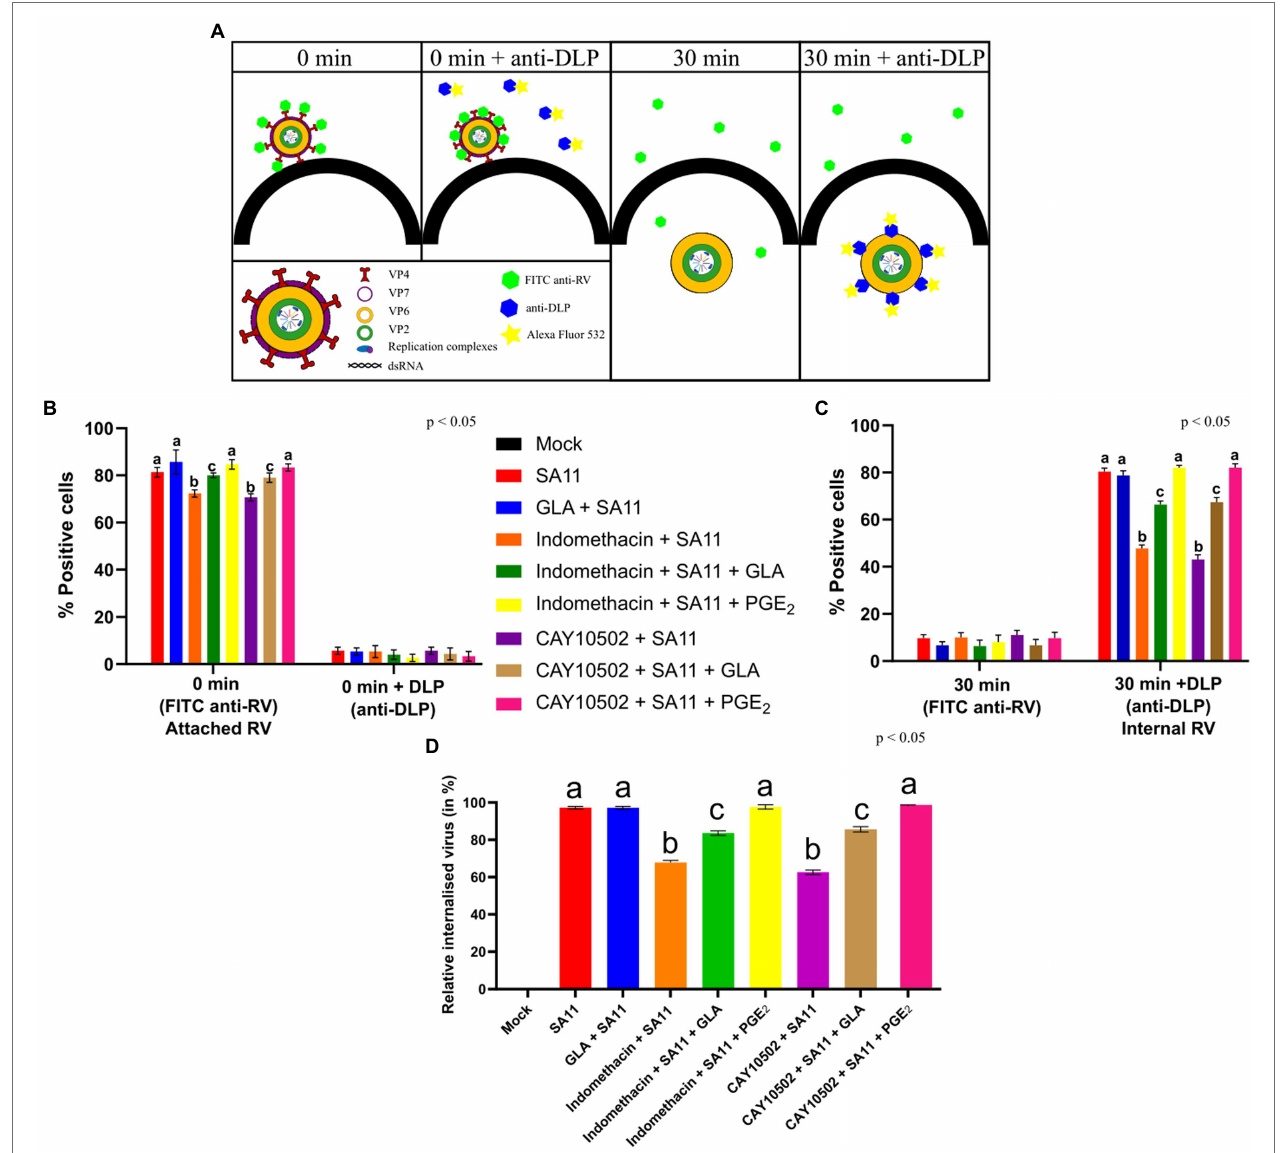
FIGURE 5 | Inhibition of PGE2 biosynthesis affects RV attachment and internalisation. (A) At time zero, RV at an MOI = 10 is cold-bound to MA104 cells and is visualised by anti-RV-FITC labelling, which detected the outer capsid protein VP7. When labelling with anti-double-layered particle (DLP) is applied, virus at the cell surface cannot be detected as the antibodies target the middle-layer protein, VP6, which is only accessible after the outer layer has been shed. Thus, the signal intensity of 0 min + anti-DLP is strongly reduced compared to 0 min + anti-RV due to the inability to detect VP6. When the temperature is increased, RV is internalised and the loss of the outer capsid allows for the detection of VP6, i.e., DLPs, to be accessible for staining. (B) Graph showing a higher positive detection of anti-RV- FITC compared to anti-DLP at 0 min. (C) Graph showing a higher positive detection of anti-DLP compared to anti-RV-FITC at 30 min. (D) Relative percentage of internalised virus from untreated and inhibitor-treated cells at 30 min post-infection is calculated by dividing the relative internalised RV (30 min) (C) by relative attached RV (0 min) (B) . Error bars indicate the standard error of the mean ( n = 3). Lowercase letters indicate significant differences ( p < 0.05) compared to the